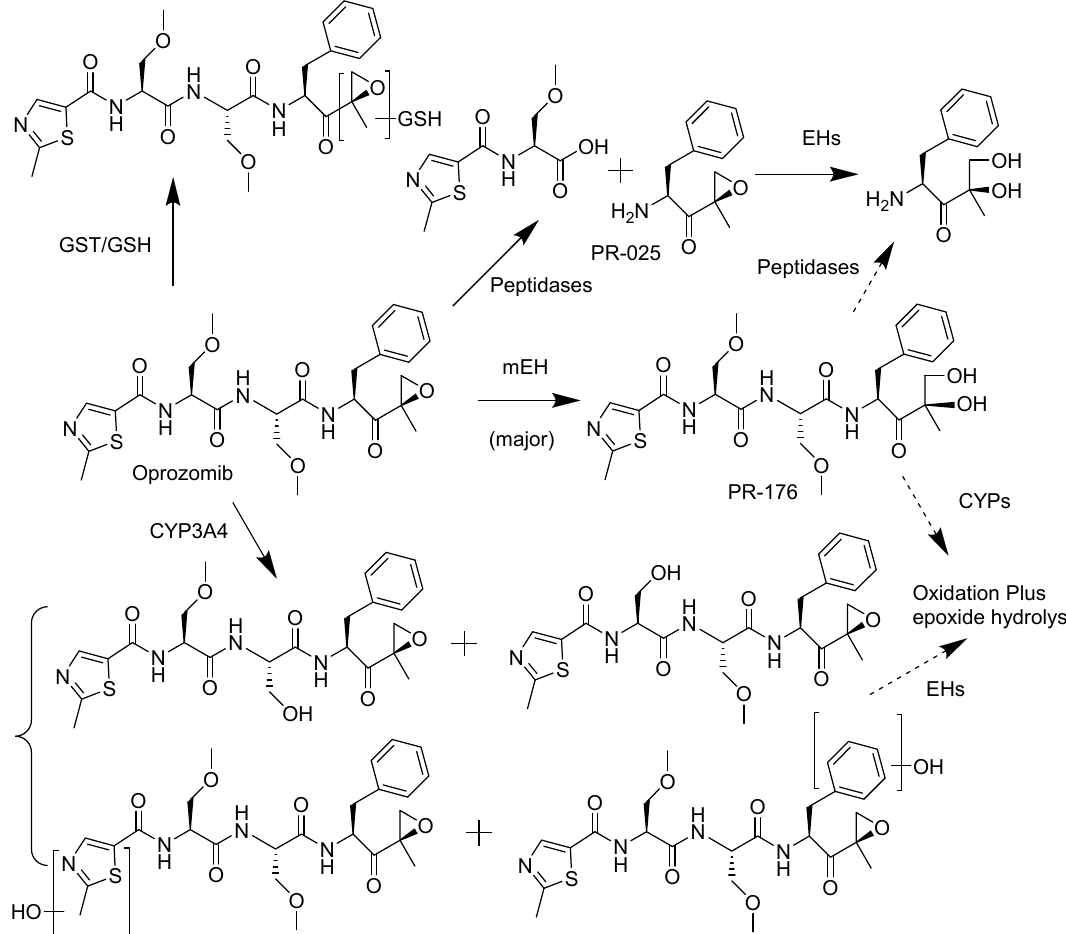
Scheme 4. Metabolic pathway of oprozomib by mEH, peptidases, and